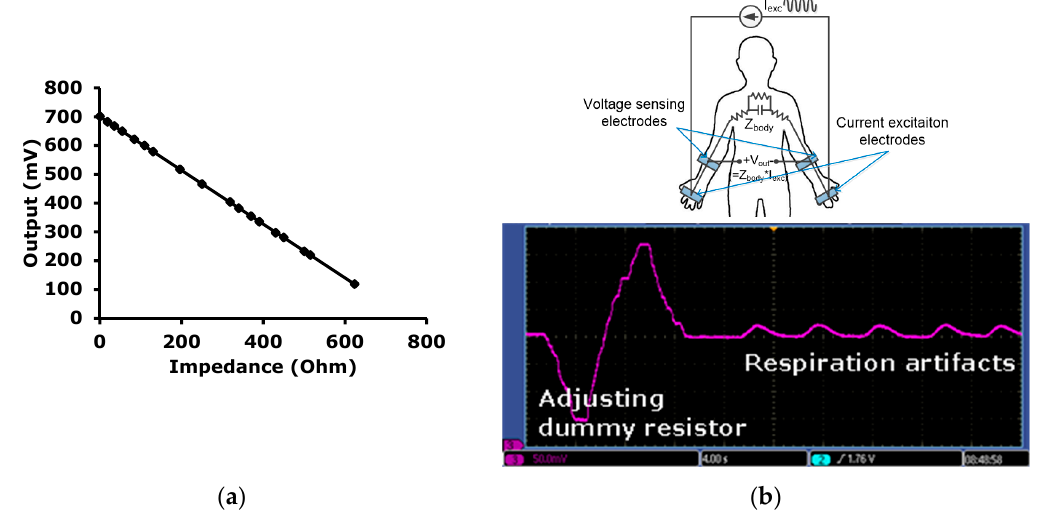
Figure 13. Measurement results in the IMP sensing mode; ( a ) Input-output characteristics; ( b ) DC trimming by changing the value of the dummy resistor and respiration signal.